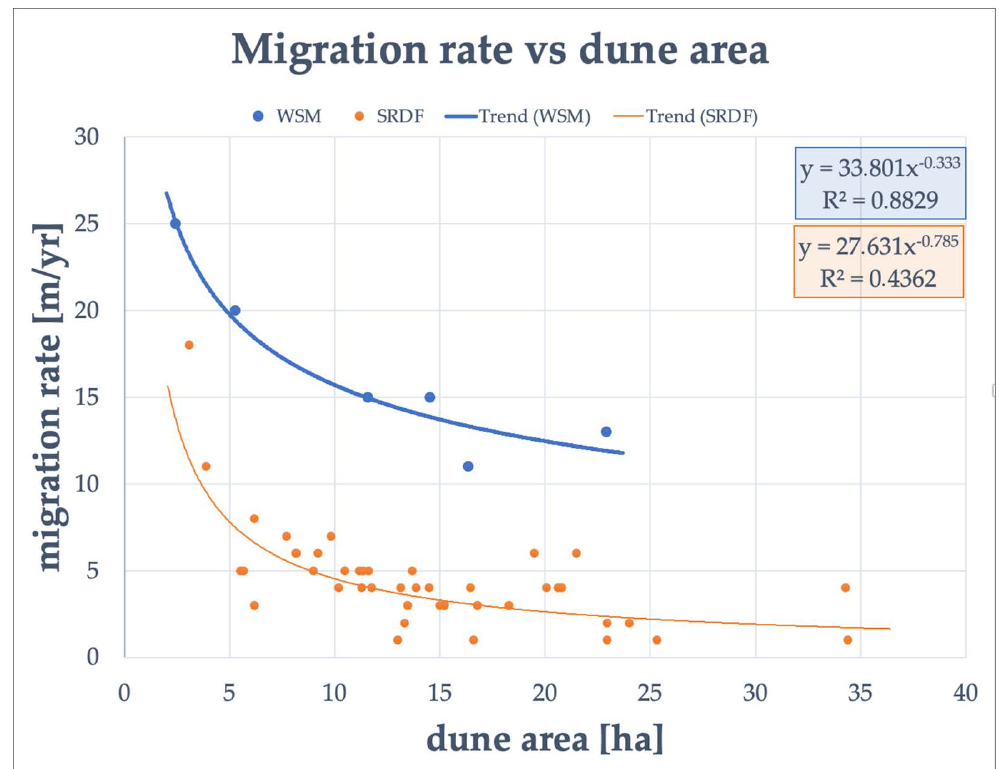
Figure 16. Curve dune area versus migration rate for the WSM and SRDF sites, including trend